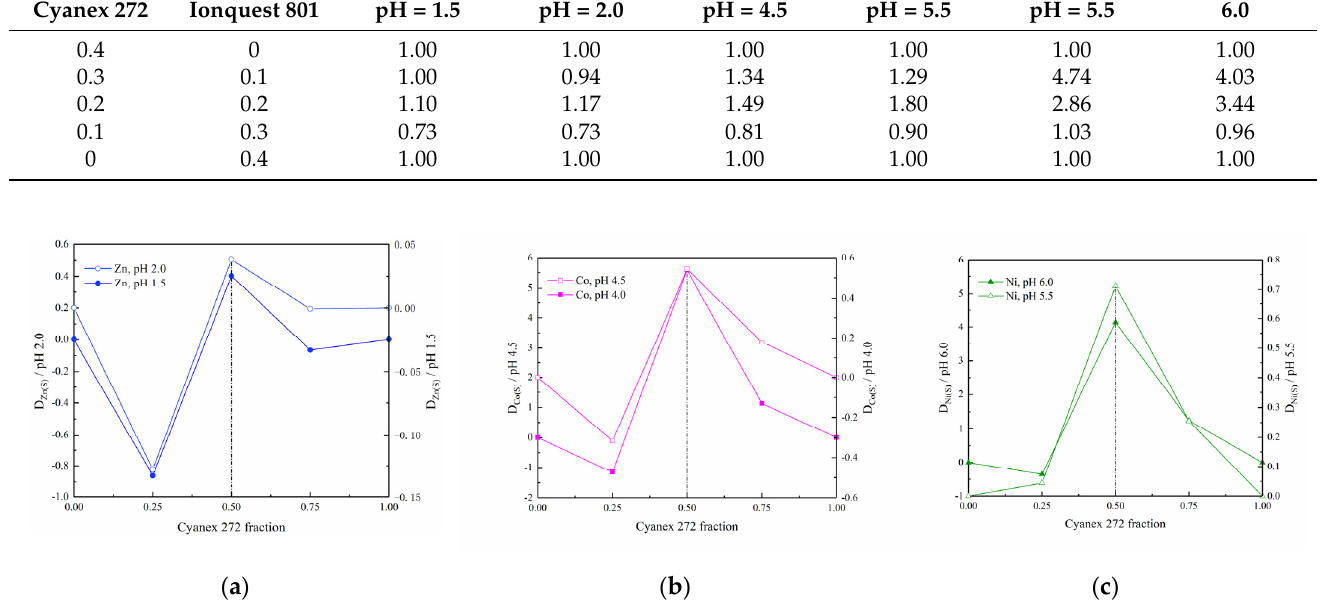
Table 7. Synergistic coefficient for metal extraction ( SC M ) using the mixture of Cyanex 272 and Ionquest 801. Organic Concentration ( M ) SC Zn SC Co SC Ni